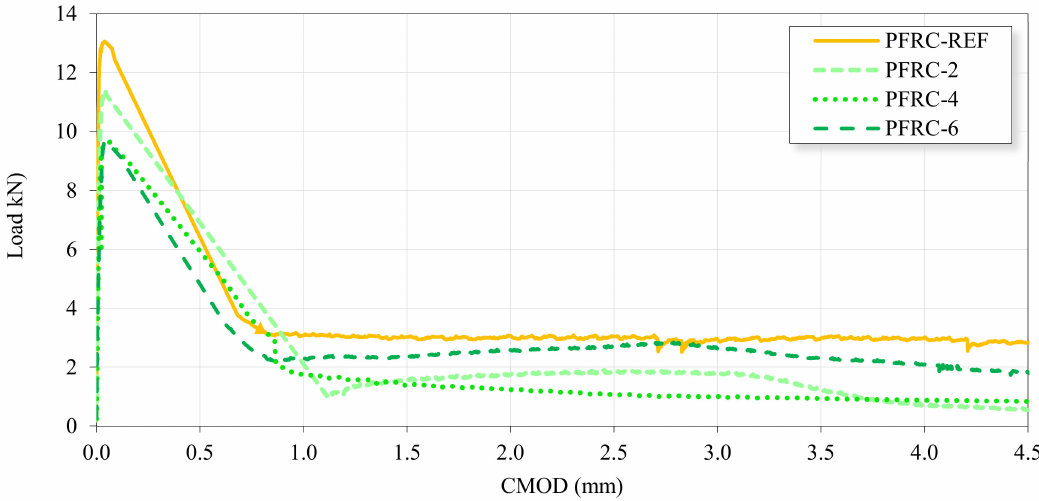
Figure 5. Average load–CMOD curves of three specimens of each concrete